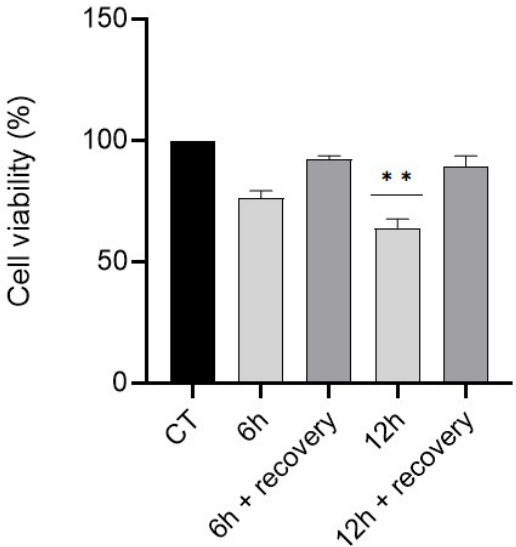
Figure 3. GC-1 cells recovery upon NPs exposure. Results from viability assay analysis of GC-1 cells after their incubation with 20 µ g/mL of ZnO NPs, for 6 and 12 h, and after a recovery period of 4 days. The percentage of viable cells for each condition was plotted as the mean ± SEM of four independent experiments. Values are expressed as arbitrary units, and the cell viability of the control condition was given a value of 100. ** p < 0.01 compared to the control group, using one way ANOVA. CT: control.